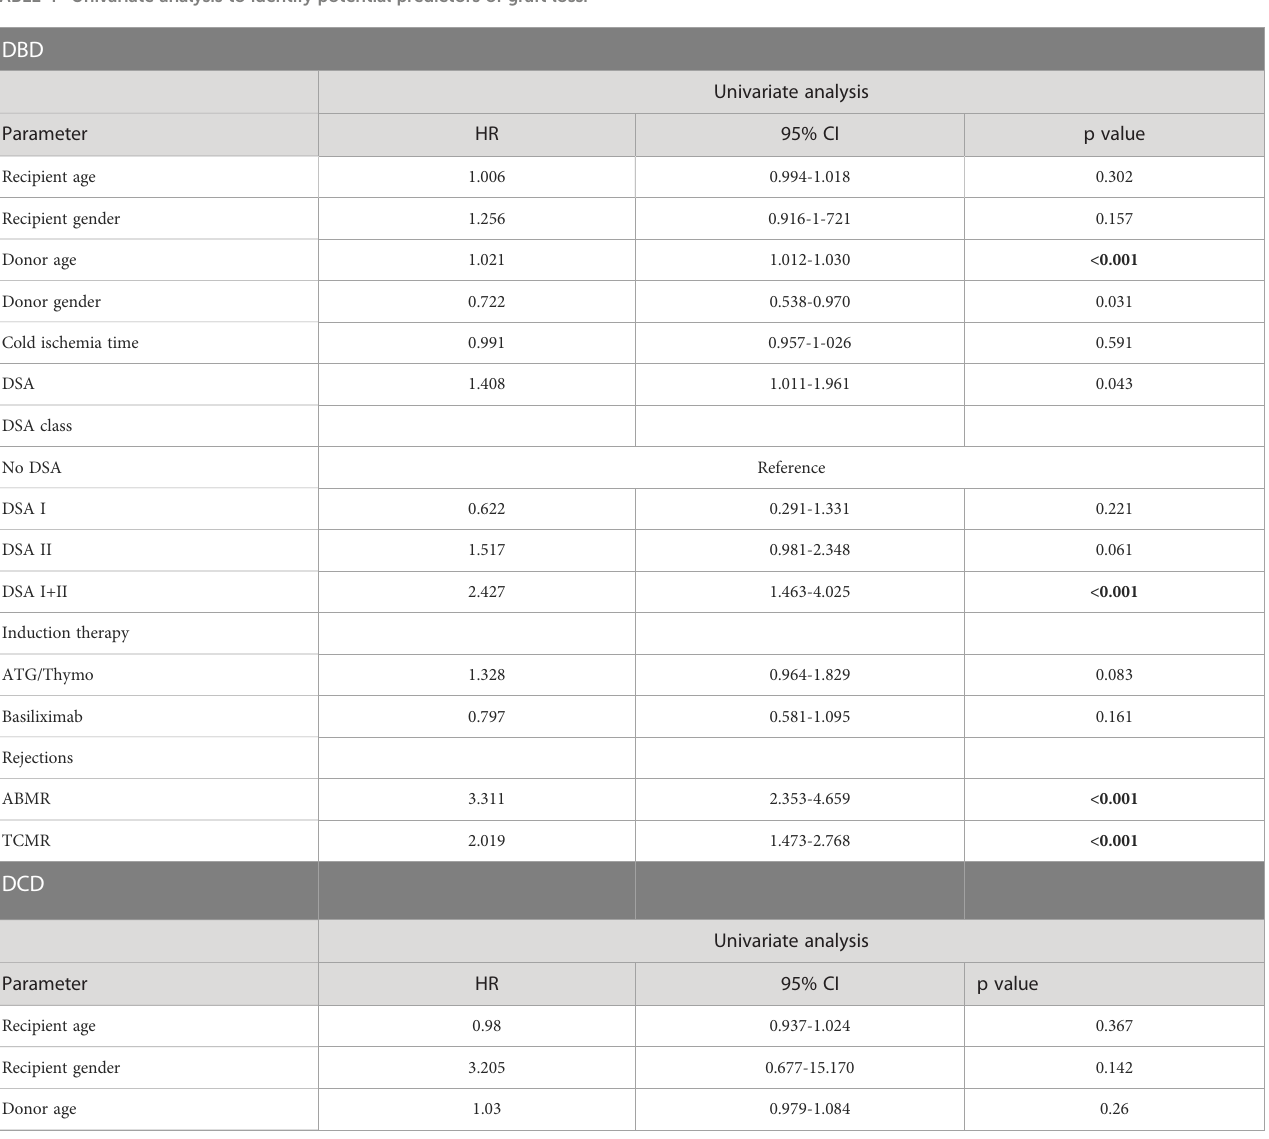
TABLE 4 Univariate analysis to identify potential predictors of graft